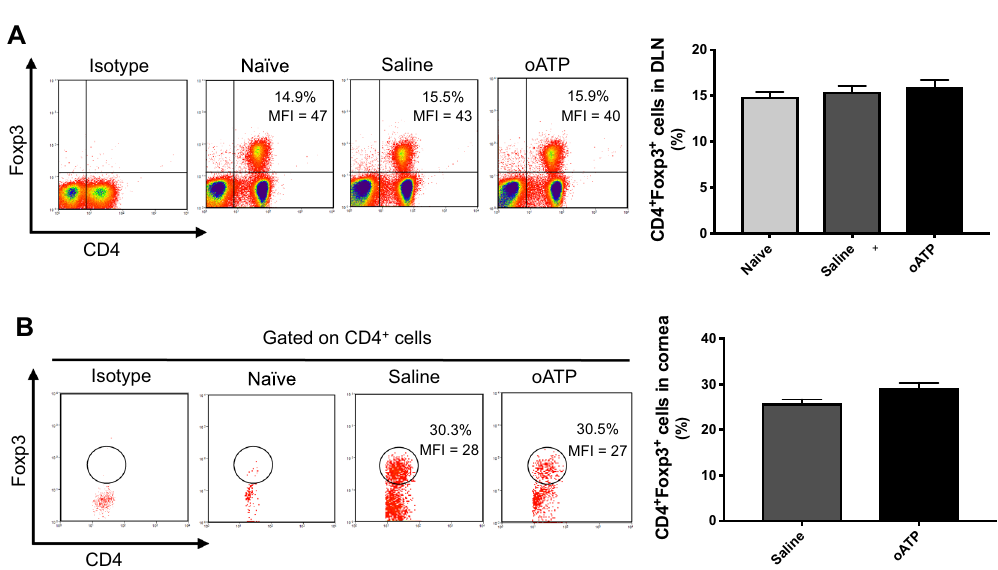
Figure 3. oATP treatment does not promote the significant expansion of regulatory T cell frequencies following corneal transplantation. ( A ) Representative flow cytometric dot plots (left; with Foxp3 MFI) and cumulative bar chart (right) showing the frequencies of CD4 + Foxp3 + cells in the draining lymphoid tissue of oATP-treated recipients, saline-treated recipients and naïve mice. ( B ) Flow cytometric dot plots demonstrating the gating strategy for enumerating CD4 + Foxp3 + cells (gated on CD4 + cells) in the cornea (left), with protein expression (median fluorescence intensity; MFI) of Foxp3 detailed. Bar chart (right) summarizes the frequencies of corneal CD4 + Foxp3 + cells at day 14 post-transplantation in oATP-treated and saline-treated recipients, relative to naïve mice. n = 5–7/group. Representative data from three independent experiments are shown, and data are depicted as mean ±